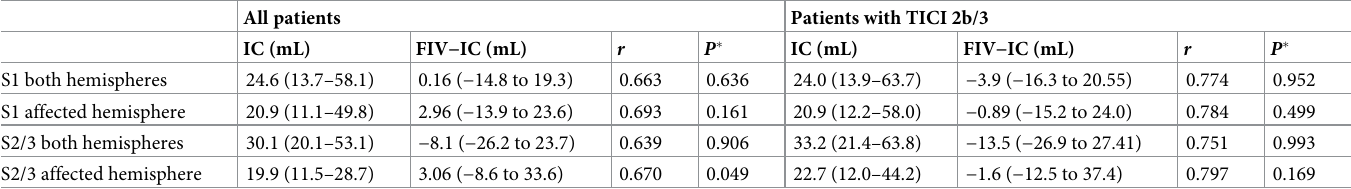
Table 2. Associations between the ischemic core volume and final infarct volume in all patients and those patients with a successful recanalization (TICI 2b/3). All